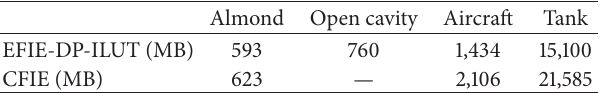
Table 4: Comparison of memory requirement of EFIE-DP-ILUT and CFIE for 3D scattering.